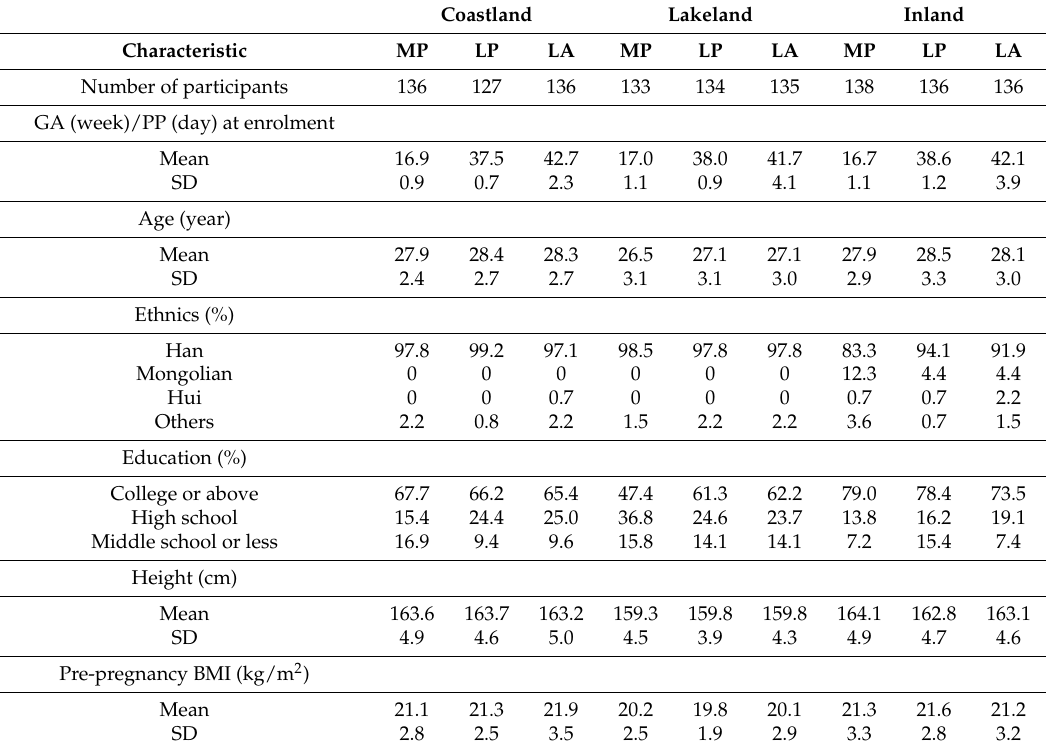
Table 1. Maternal characteristics by region and participant